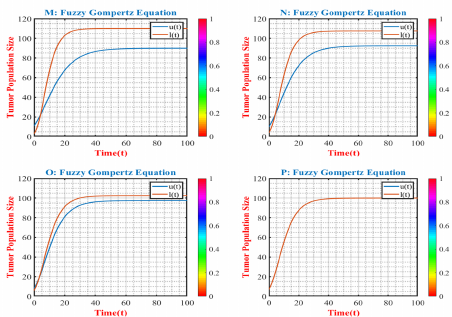
Figure 6. In this case, the system of Gompertz equation full fuzzy i.e., initial condition, coefficient and car- rying capacity all are fuzzy is defined and the tumor population size as a function of time for α = 0, α = 0 . 25, α = 0 . 75 and α = 1 are